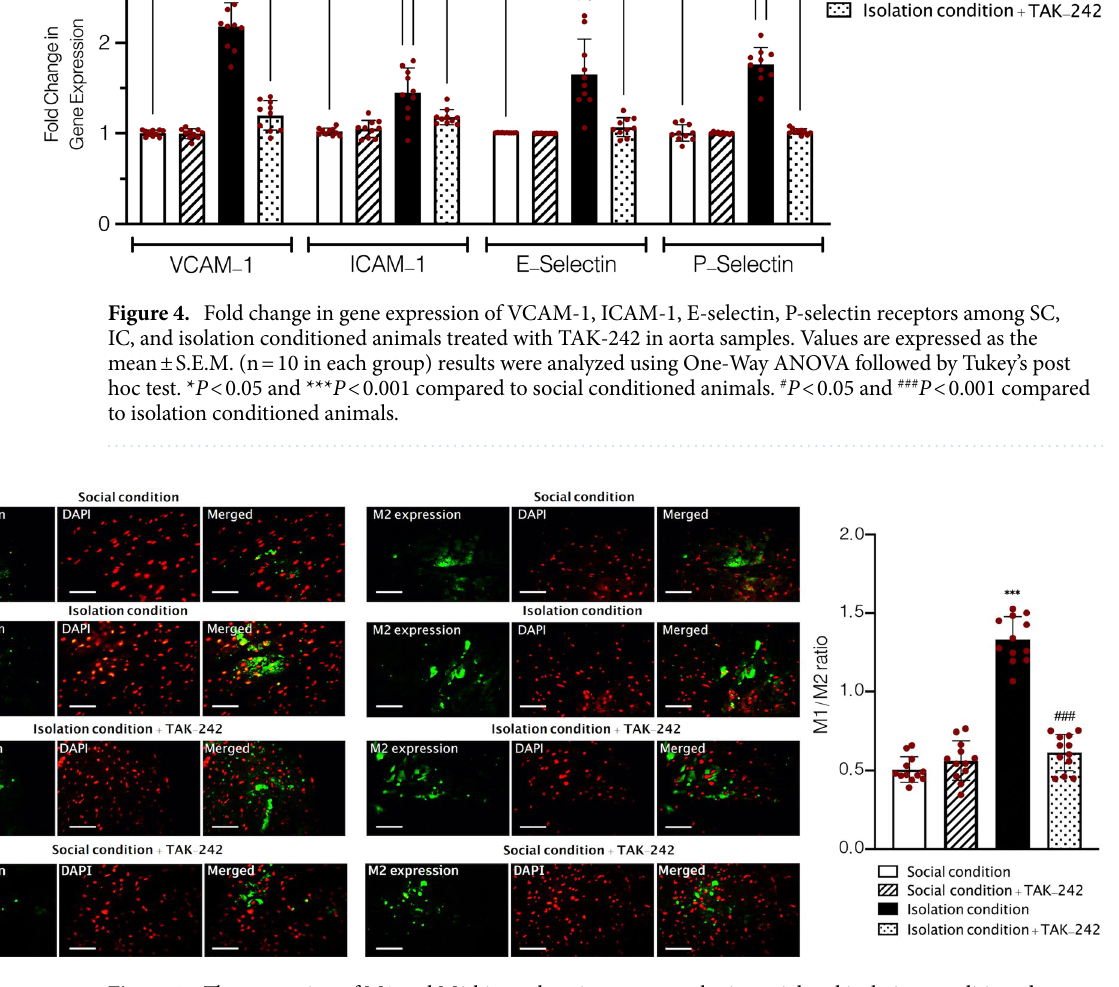
Figure 5. The expression of M1 and M2 biomarkers in aorta samples in social and isolation conditioned animals. Values are expressed as the mean ± S.E.M. (n = 12 in each group) results were analyzed using One-Way ANOVA followed by Tukey’s post hoc test. *** P < 0.001 compared to social conditioned animals. ### P < 0.001 compared to isolation conditioned animals. Bar = 100